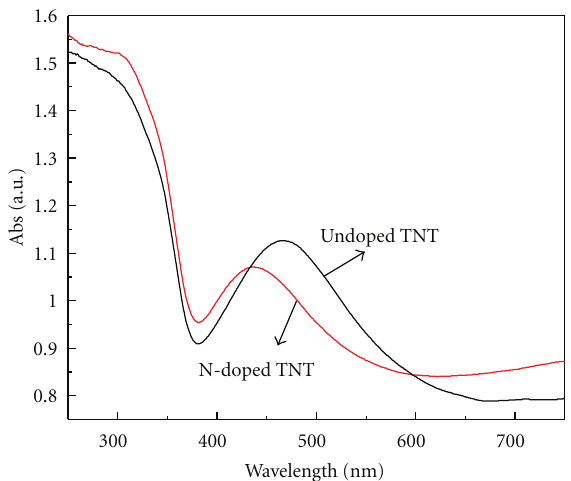
Figure 3: UV-vis absorption spectra of the undoped and N-doped TNT arrays. The doping conditions are that reaction voltage is 3V, reaction time 3h and electrolyte concentration 0.5M.